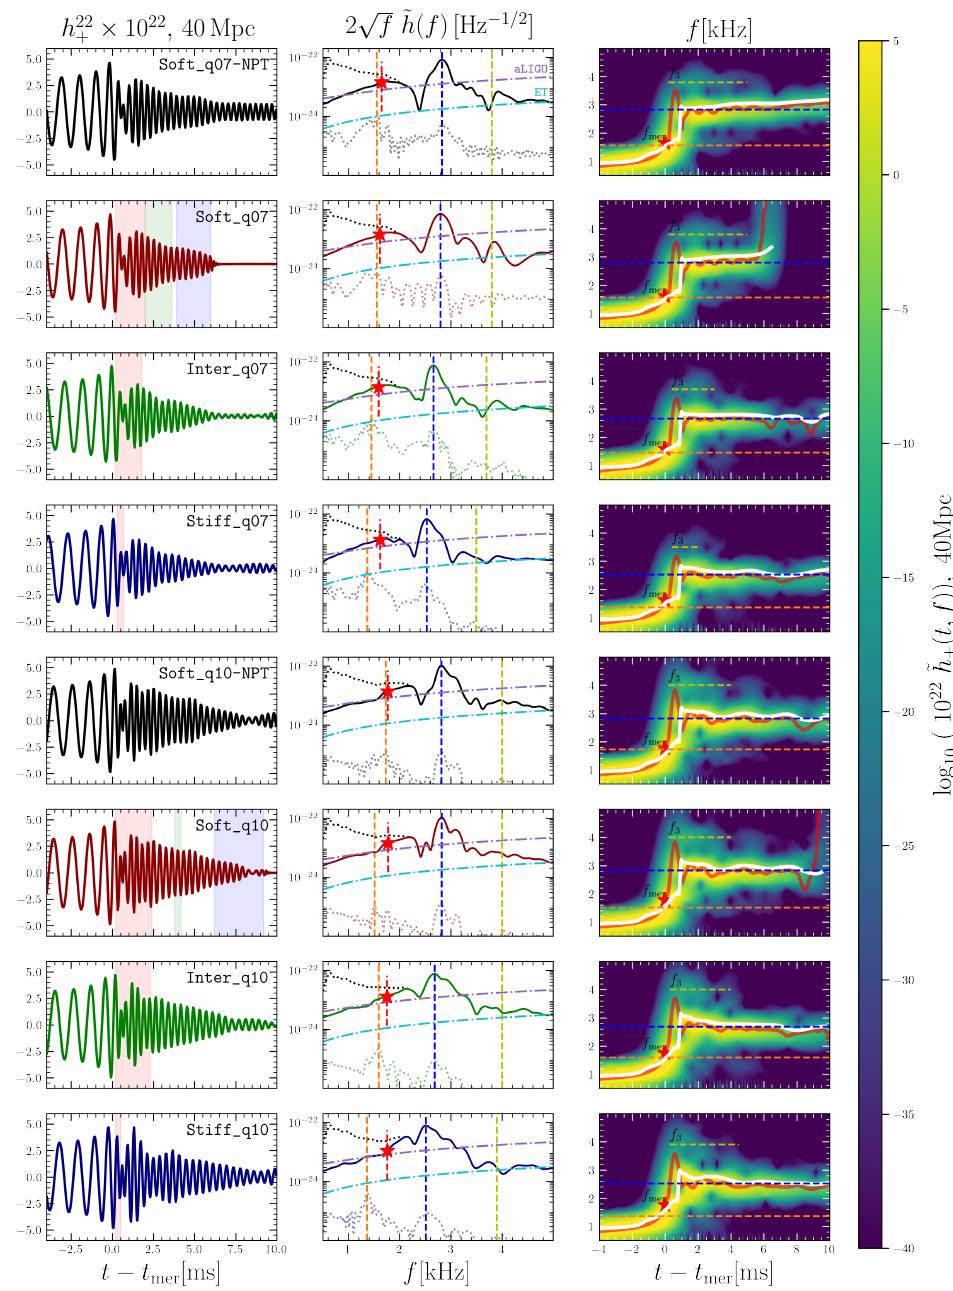
Figure 5: Shown above is the h 22 of the strain, the power-spectral density of the effec- + tive strain, and the spectrogram of the h 22 of the Soft , Inter , and the Stiff EOSs + = 1.188. Also included are the considered in this work for q = 1,0.7 and M chirp related spectra for Soft-NPT which does not include a phase transition to quark matter. In the right two panels the dashed blue and orange lines correspond to the f 2,2 and f 2,1 peaks respectively, the dashed yellow lines corresponds to the f peak 3 as measured in the spectrogram, and the star denotes the peak merger frequency, f . In the right figure, the white line traces the maximum in the spectrogram. Fi- mer nally, the sensitivity curves in the middle plot are related to the current sensitivity of advanced LIGO and the Einstein Telescope respectively [ 75,76 ]